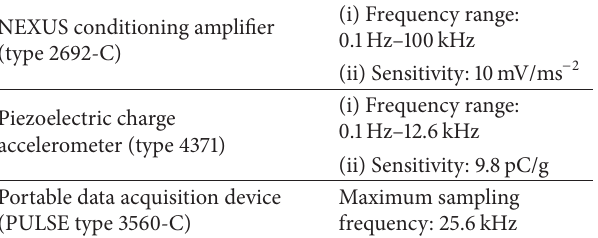
Table 1: Summary of specifications of the data acquisition